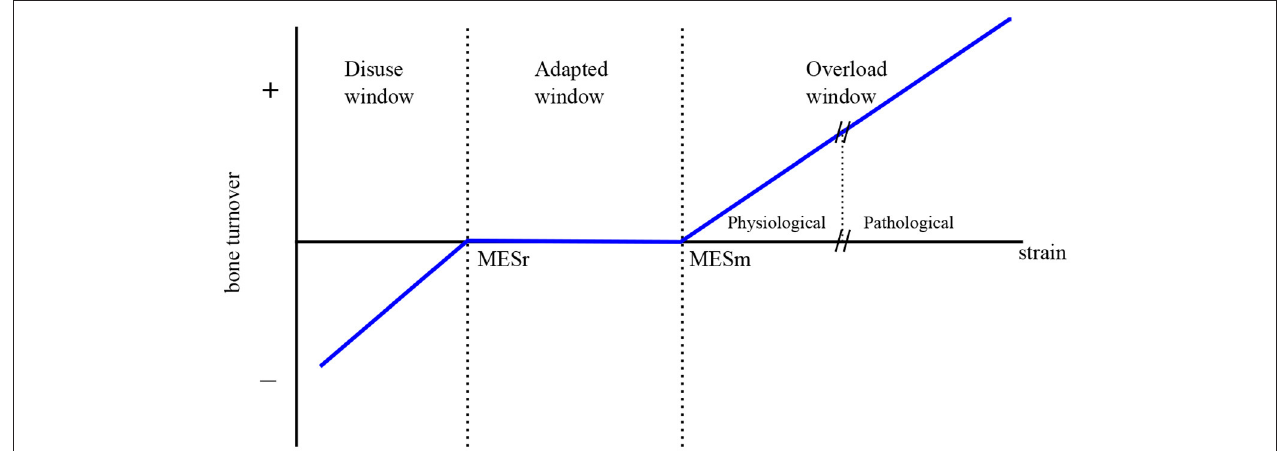
FIGURE 2 | The Mechanostat Theory (adapted from Frost, 2003).